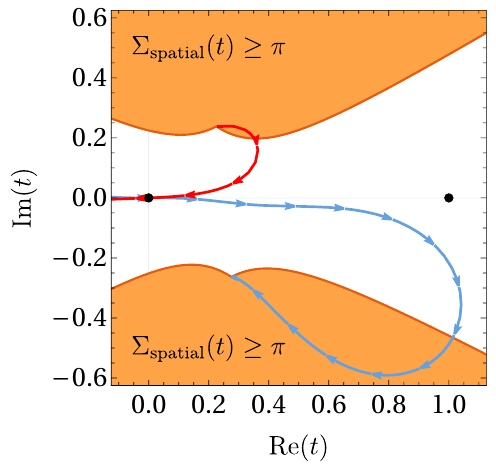
Figure 7 . Same plot as on the left-hand side of figure 6, except now the lapse is taken to have the value N = 4 − i/ 10 , which is just off-shell of the bouncing saddle point. We added shaded regions, which correspond to non-allowable metrics according to the spatial LSKSW criterion alone, i.e., in these regions 3 | Arg[ q ( t )] | ≥ π . Time paths respecting the full LSKSW bound must reside in between the blue and red directed lines, hence it is impossible to reach t = 1 in this example, and the metric is thus not allowable. In particular, a path reaching t = 1 necessarily has to cross the blue line, where we know Σ = π